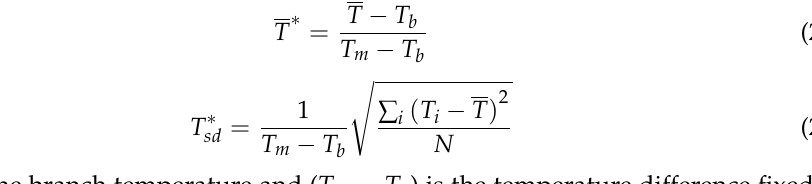
Figure 8. Temperature distribution downstream of I-ref case using LES and ELES: ( a ) Temperature T * distribution using LES; ( b ) Temperature T * distribution using ELES; ( c ) Temperature T sd* distribution using LES; ( d ) Temperature T sd* distribution using ELES.